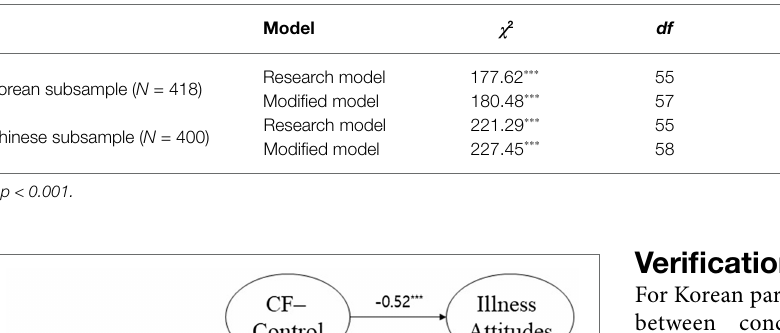
TABLE 3 | Fit of research model and of modified